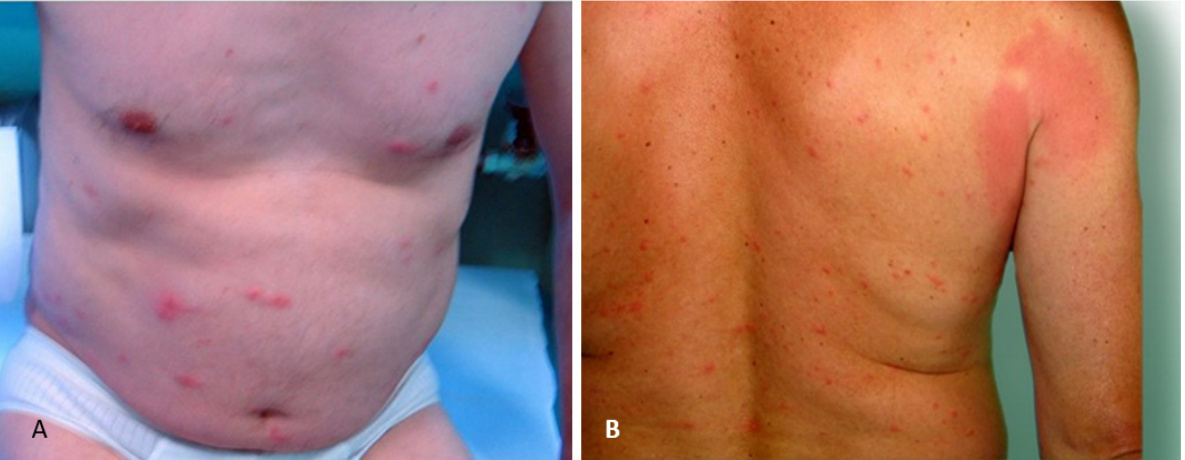
Figure 4. Skin lesions in patients with no co-morbidities bitten by blackflies for the first time. ( A ) Numerous papules and vesicles with serous discharge and erythema on the abdomen and chest in a male patient (case 3); ( B ) Numerous vesicles at the site of blackfly bites and extensive erythema on the arm in a male patient (case 4). on the arm in a male patient (case